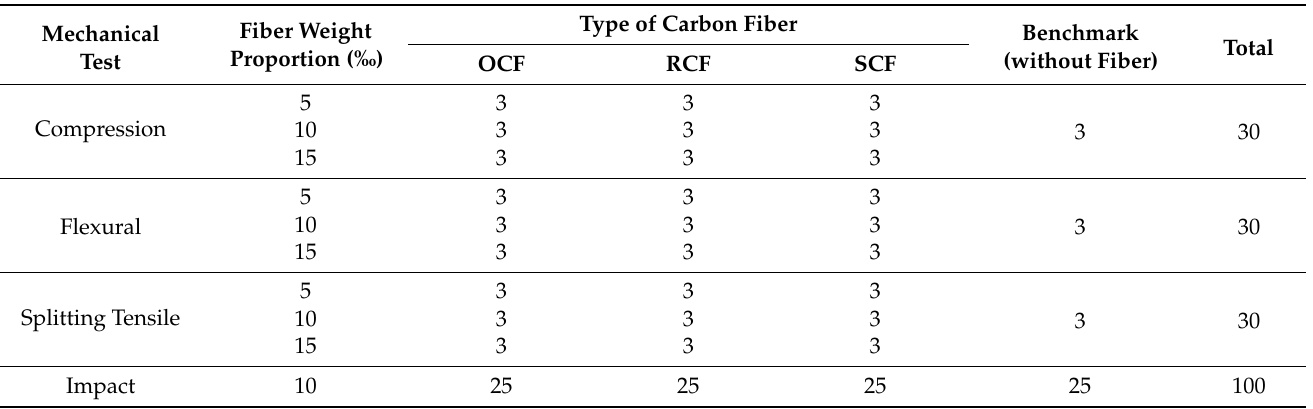
Table 4. Planning of the number of